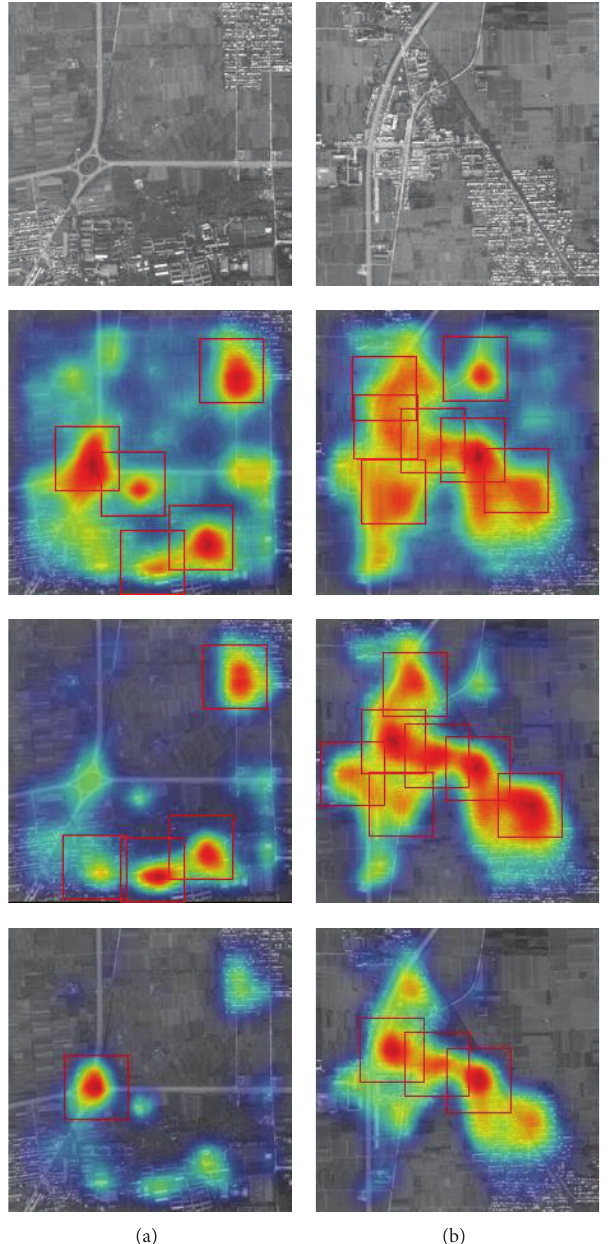
Figure 8: Results of waypoints in Class 2 (the first line is two reference images; the second line is the results of Li et al. [9]; the third line is Han et al.’s [12]; the fourth line is